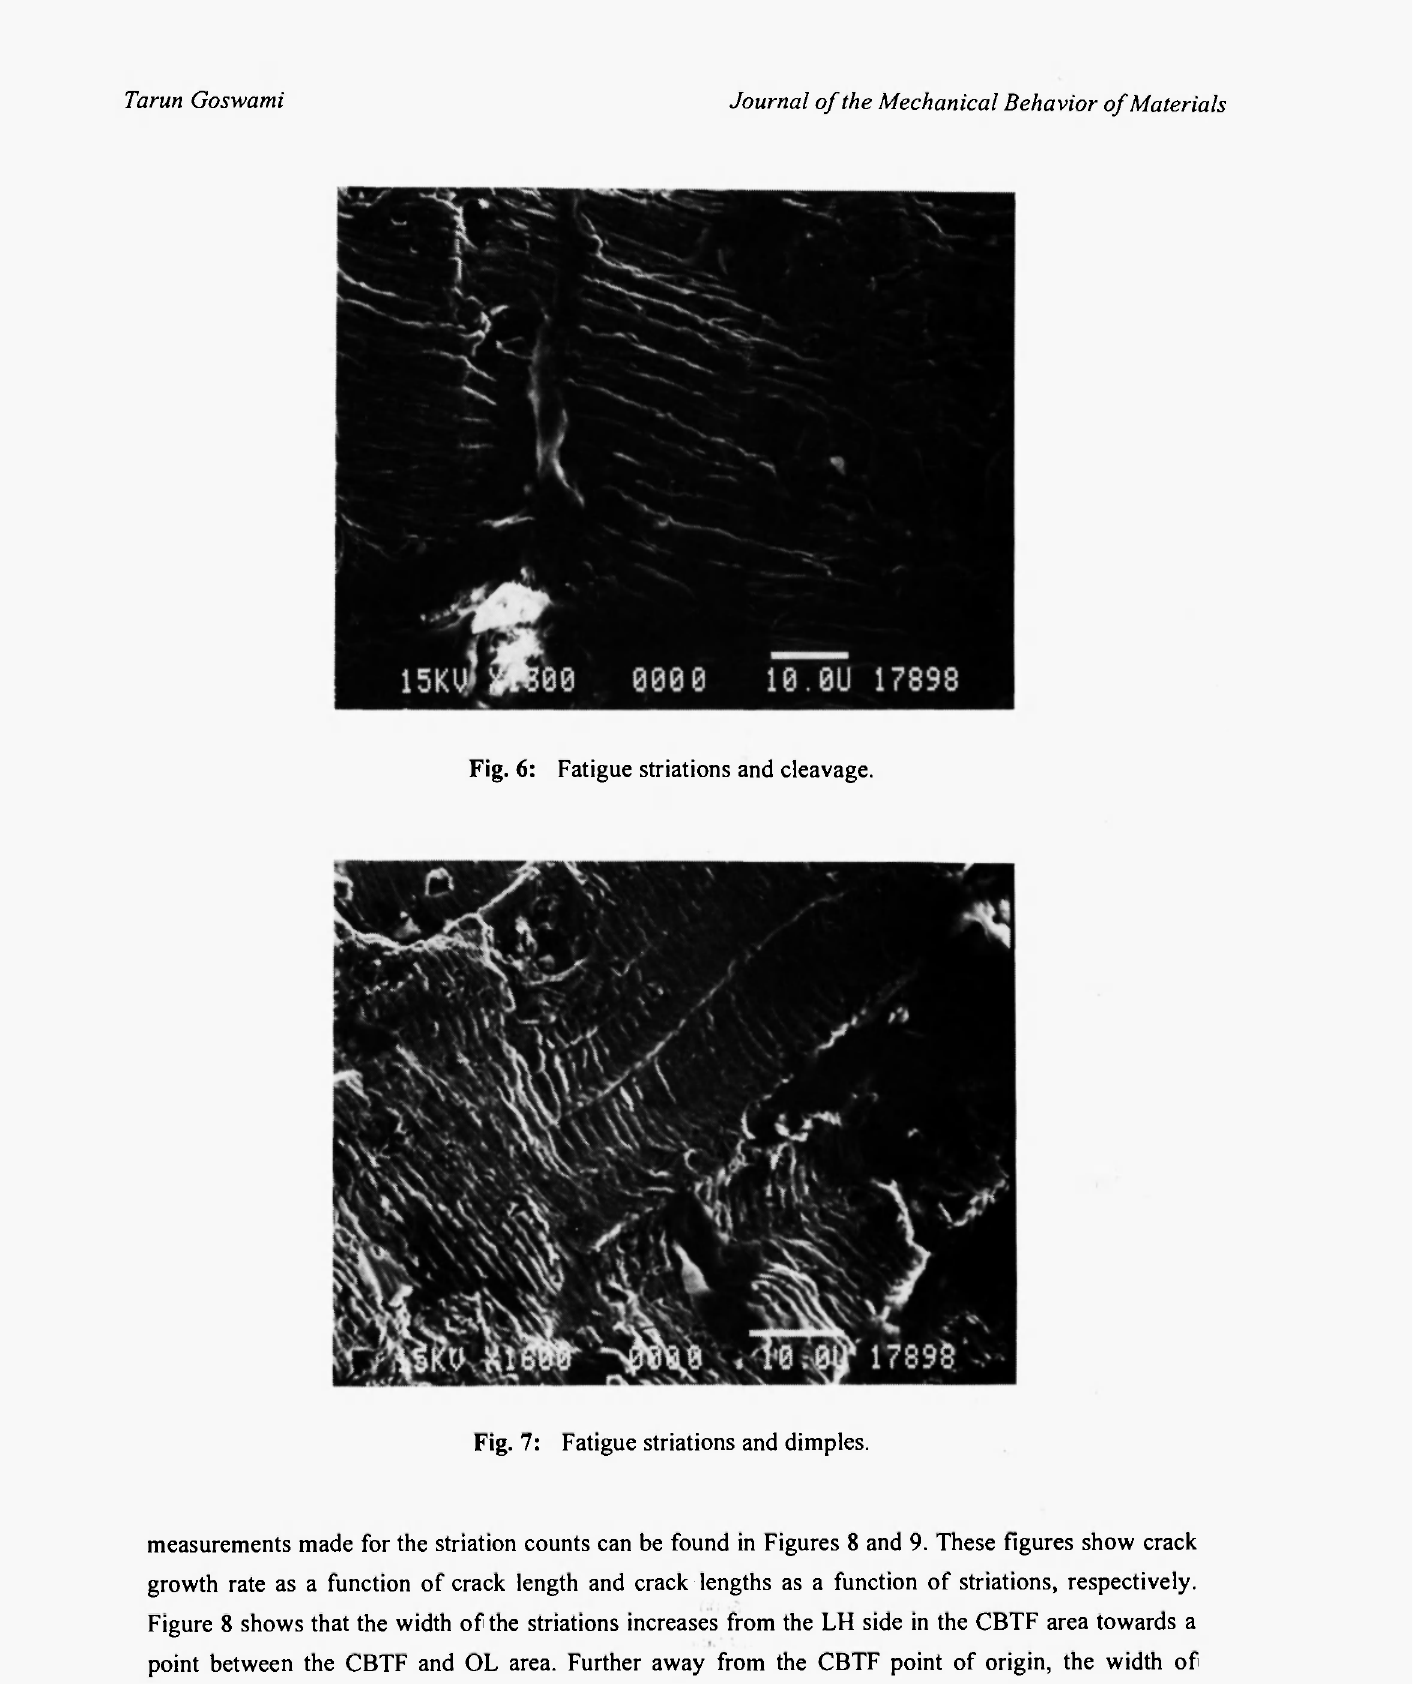
Fig. 6: Fatigue striations and cleavage.